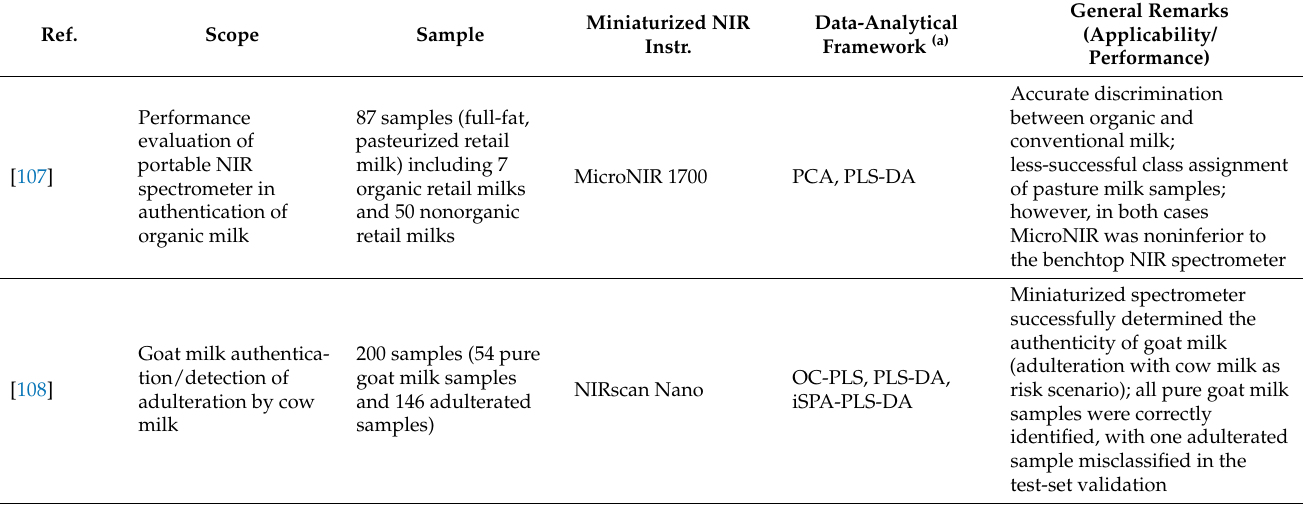
Table 3. Recent research activity oriented toward miniaturized NIR spectroscopy for analysis of milk.